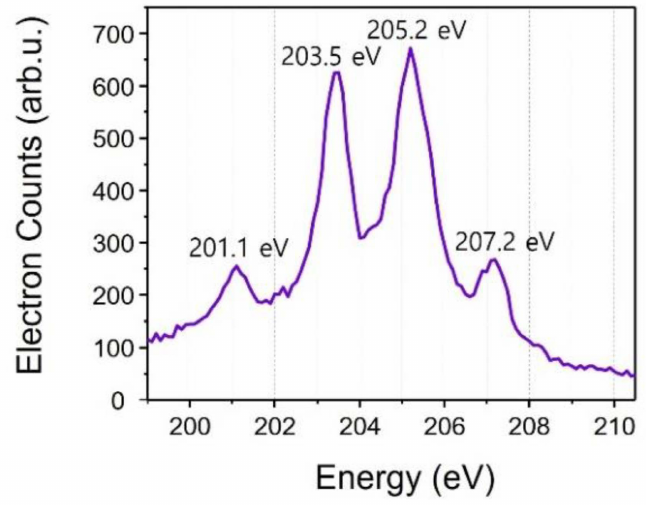
Figure 6. Argon Auger photoelectron spectrum without the IR